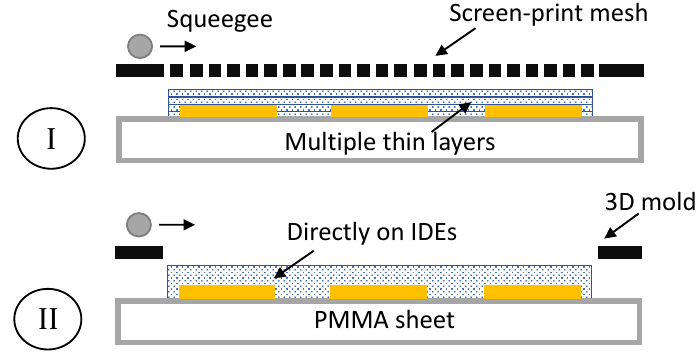
Figure 9. Schematic sensor